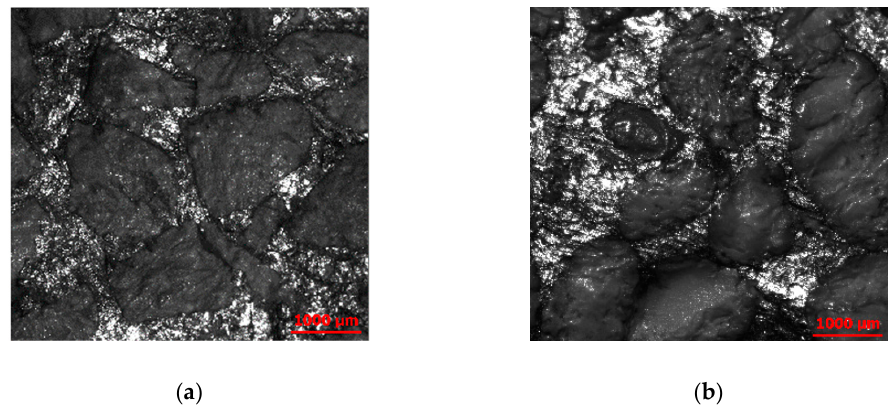
Figure 2. Images of ( a ) material 2 with black, cubic grains, and ( b ) material 5 with white, spherical grains. Both are 5140 × 4797 µ m.